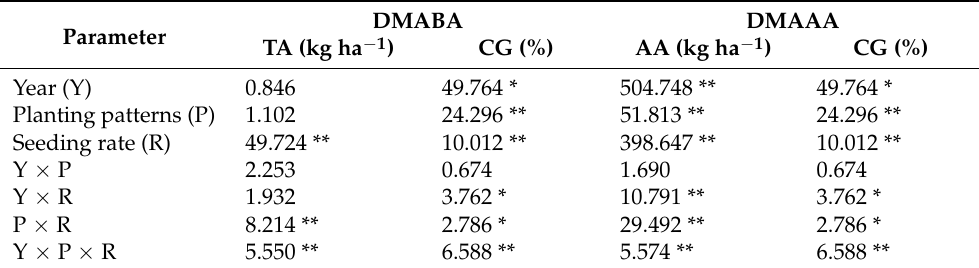
Table 4. Significance analysis (F value) of interactive effects on the accumulation and translocation of dry matter at pre- and post-anthesis period in two